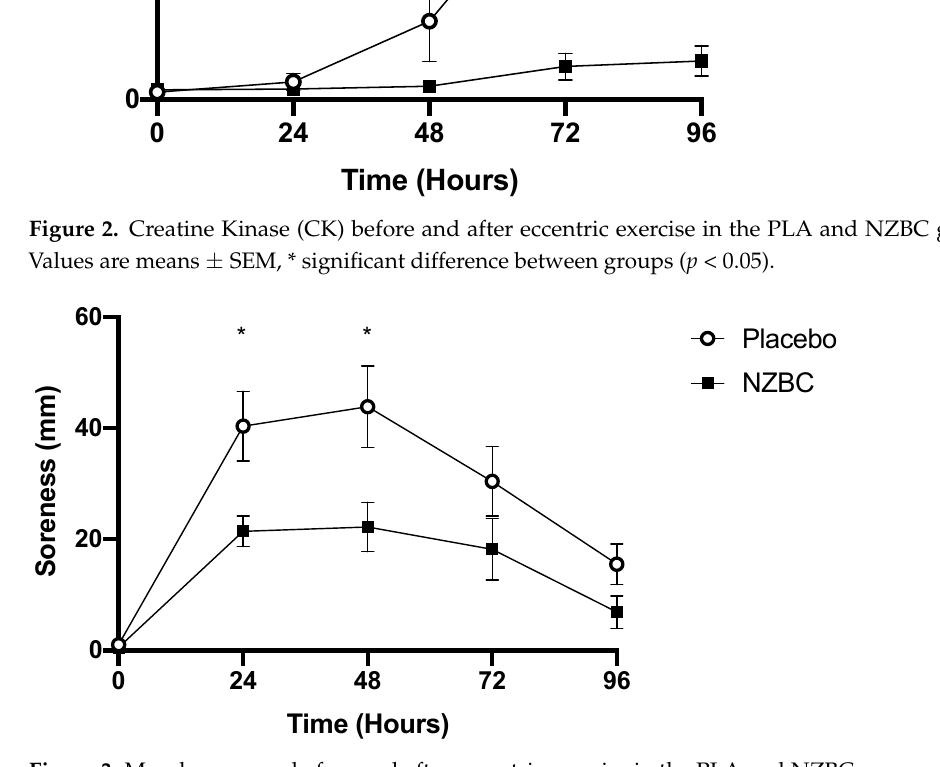
Figure 2. Creatine Kinase (CK) before and after eccentric exercise in the PLA and NZBC groups. Values are means ± SEM, * significant difference between groups ( p < 0.05).